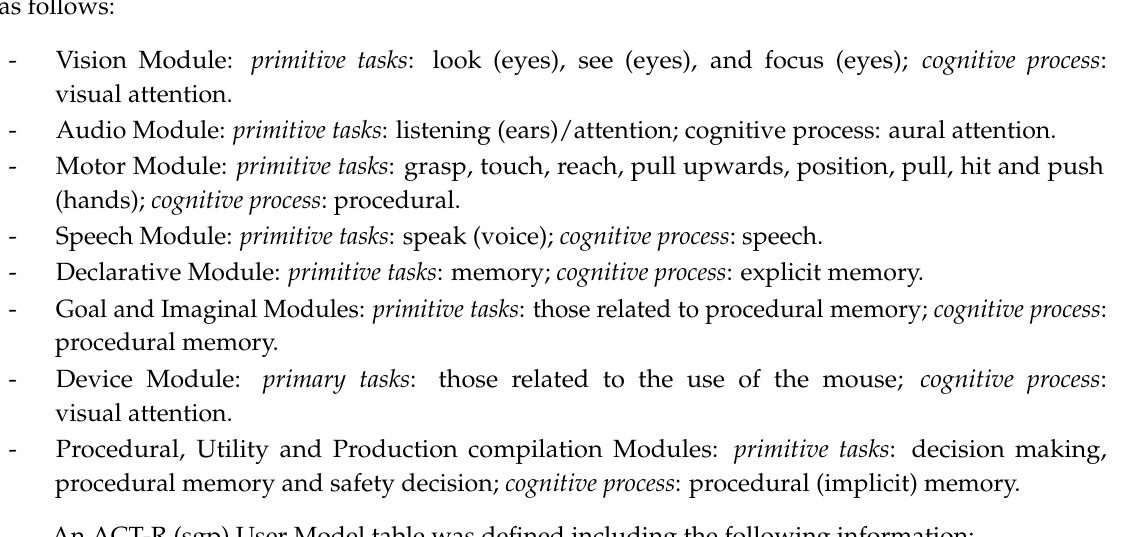
Figure 4. Structure of the ACT-R (sgp) User Model parameters. Note: Taatgen et al. [43]. 3.3. Task Model Implementation Tasks within each disability, as related to the Personal Healthcare and Wellbeing sector, were collected and analyzed. A task was defined as a group of basic actions taken by a user, and it was